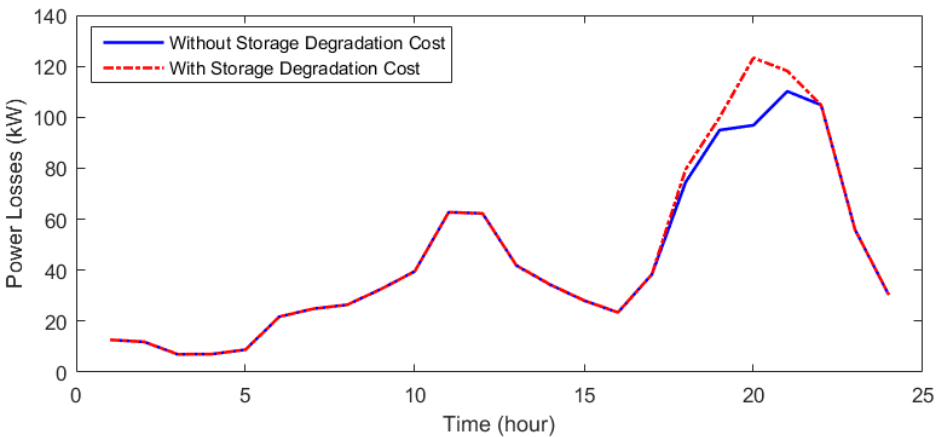
Figure 13. Power losses of the network without and with BDC in WT/Battery scheduling using the IFLA.